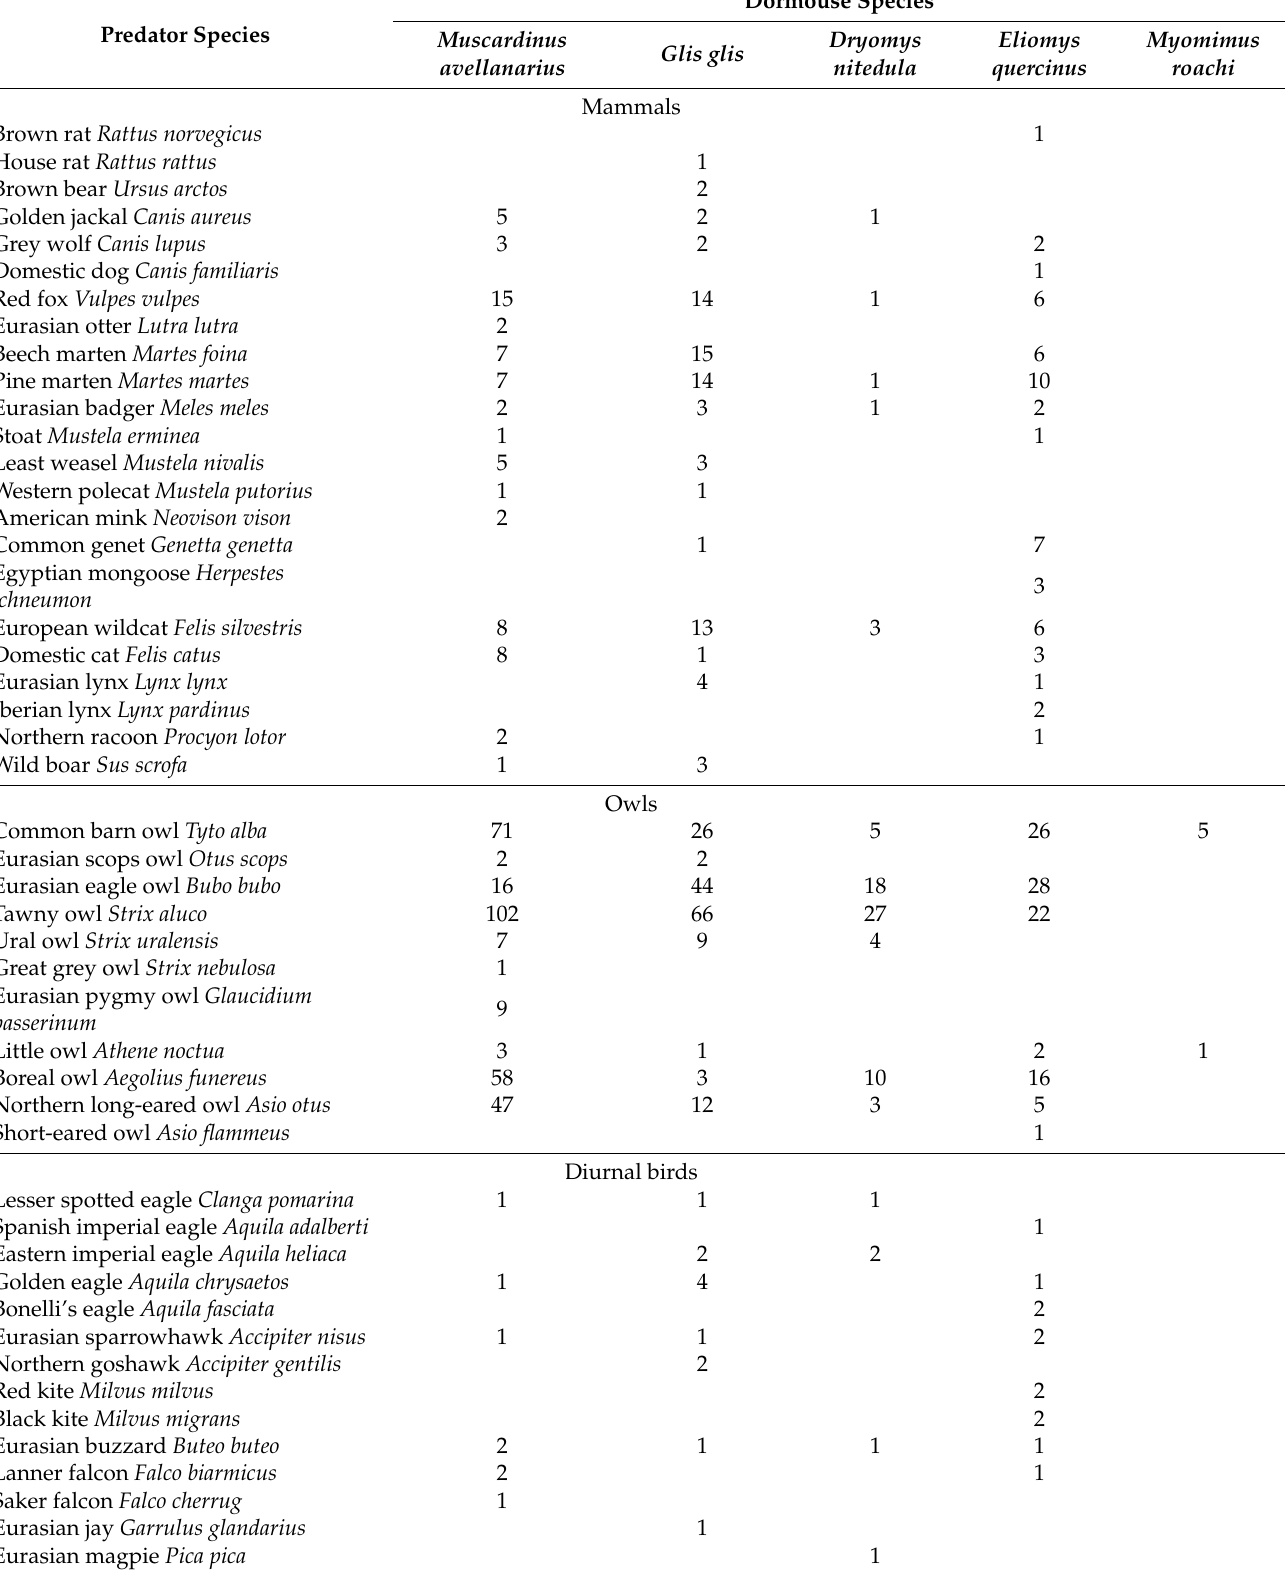
Table 1. Predators of European dormouse species and number of sources containing information about dormouse species recorded in the diets of particular